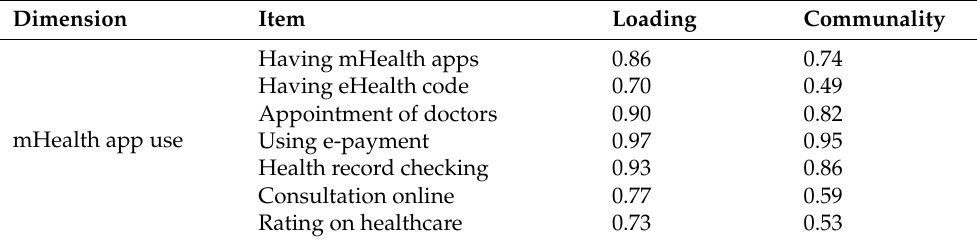
Table 2. Measurements of mHealth app use items and their reliability by exploratory factor analysis.